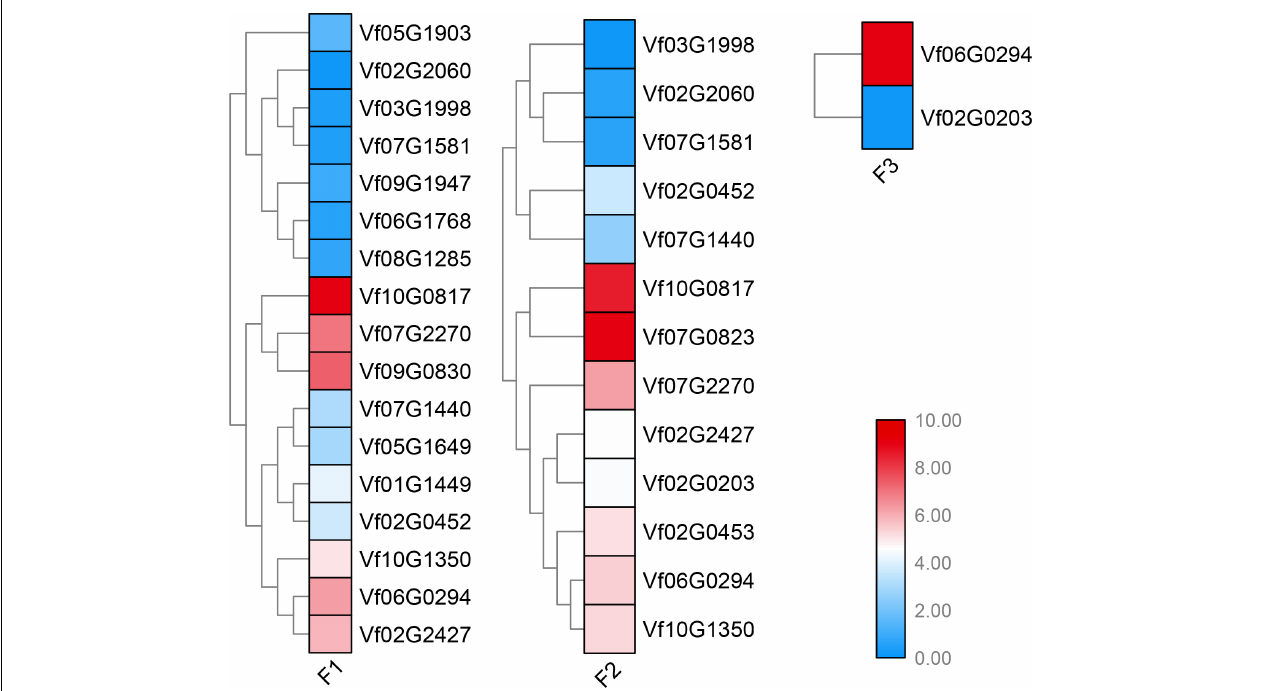
FIGURE 4 | Young duplicate genes involved in response to Fusarium wilt disease stress. The same color font suggests that a duplicate gene was simultaneously involved in Fusarium wilt disease stress over more than one